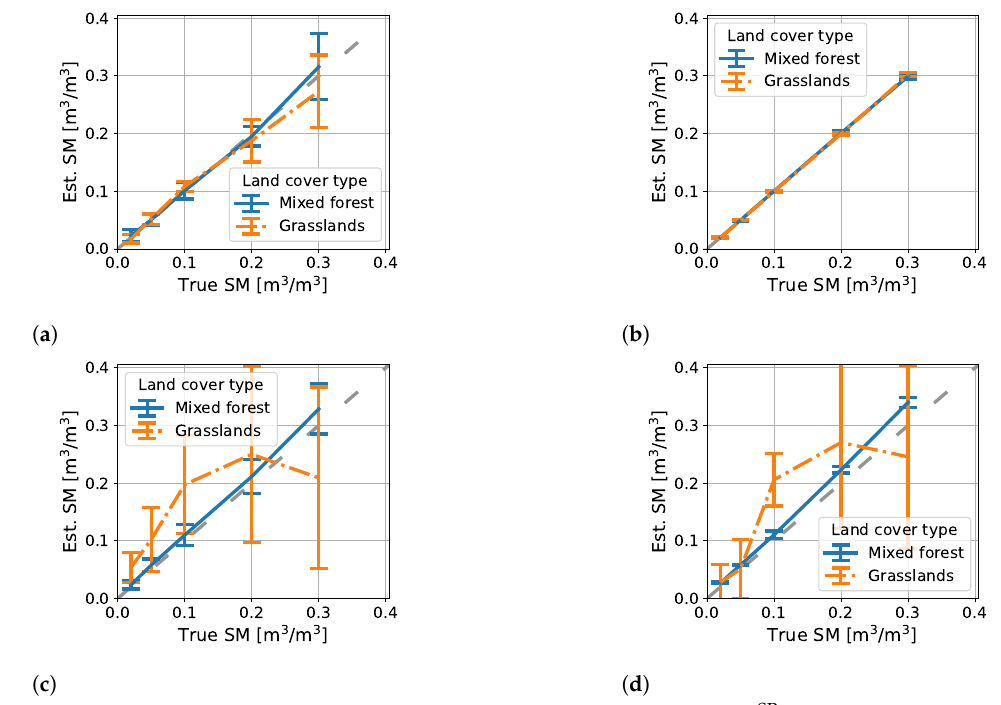
Figure 8. Soil moisture retrievals from simulated DDM; σ h = 2cm and θ SP cover types. The error bars represent one standard deviation from the mean, and the gray lines represent perfect retrievals. ( a ) First retrieval scheme, SNR = 10dB. ( b ) First retrieval scheme, SNR = 20dB. ( c ) Second retrieval scheme, SNR = 10dB. ( d ) Second retrieval scheme, SNR =